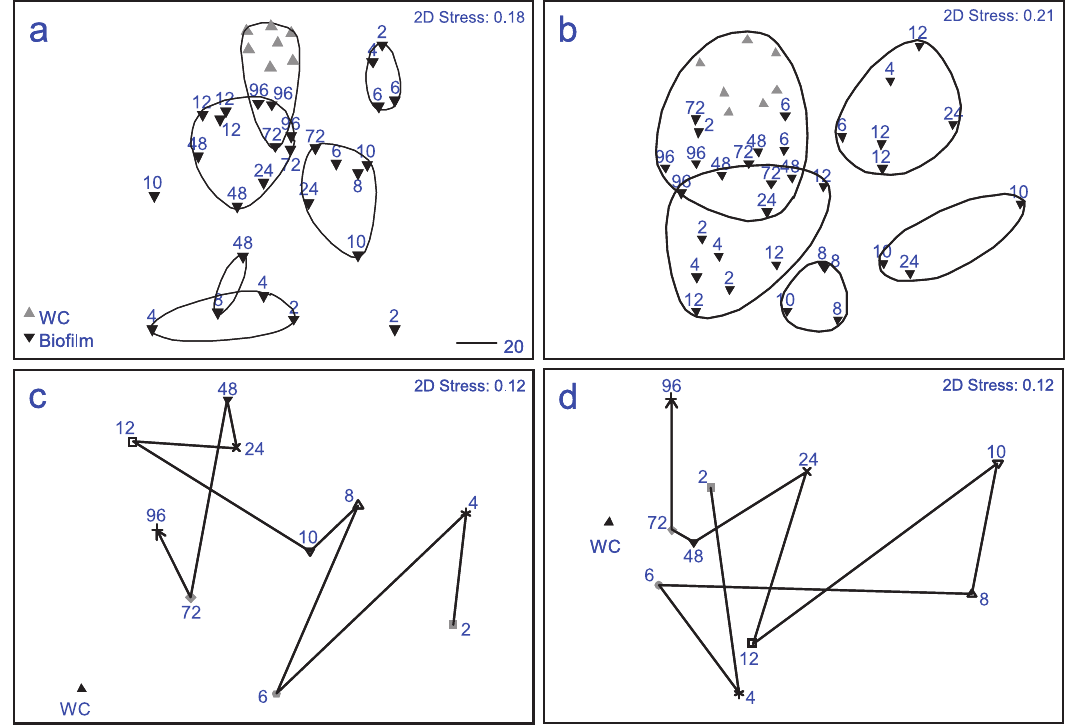
Figure 3. Multidimensional scaling plot (MDS), showing hourly changes in bacterial communities (16S rRNA gene fingerprints), developing on the biofilm of the replica coral nubbins enriched with agar; (a) winter samples (August 2008); (b) summer samples (March 2009). Averages of time periods showing trajectory of similarity between time points, (c) winter and (d) summer. WC = water column.